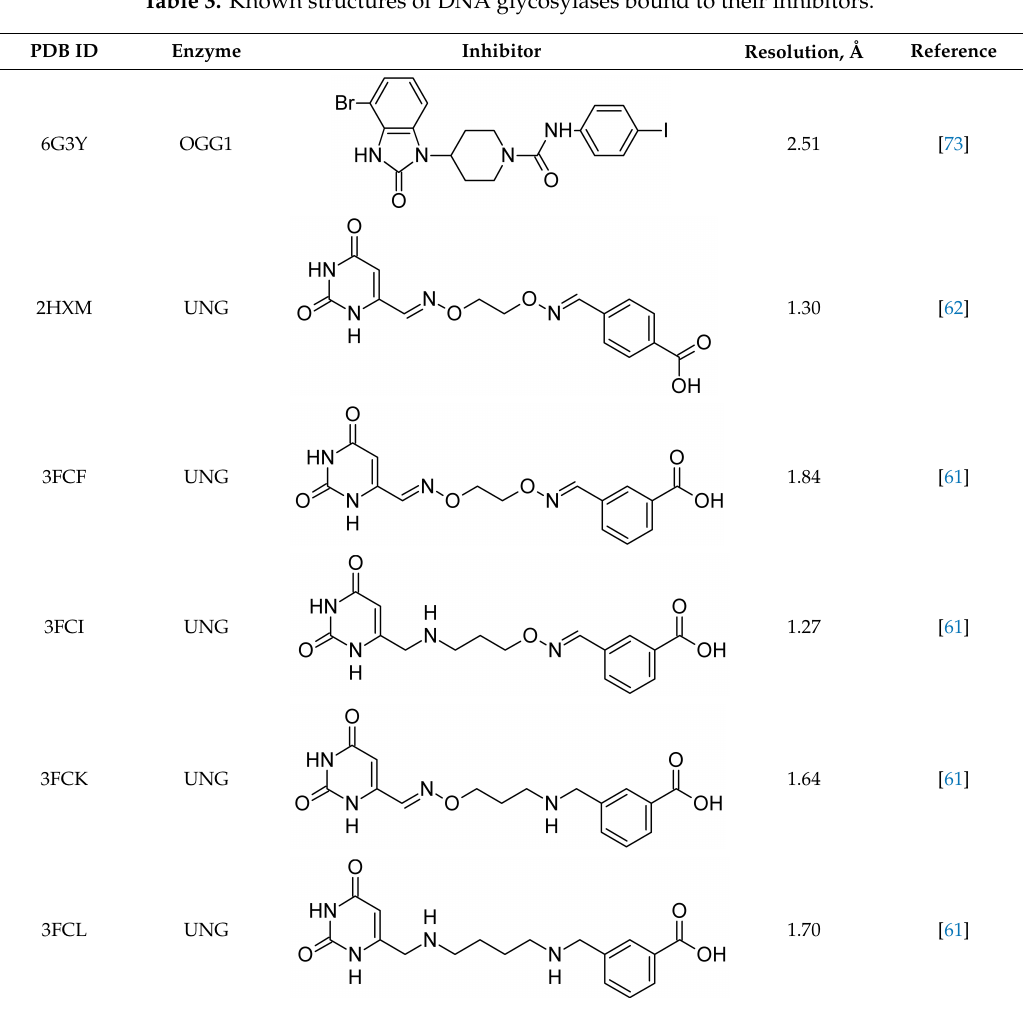
Table 3. Known structures of DNA glycosylases bound to their